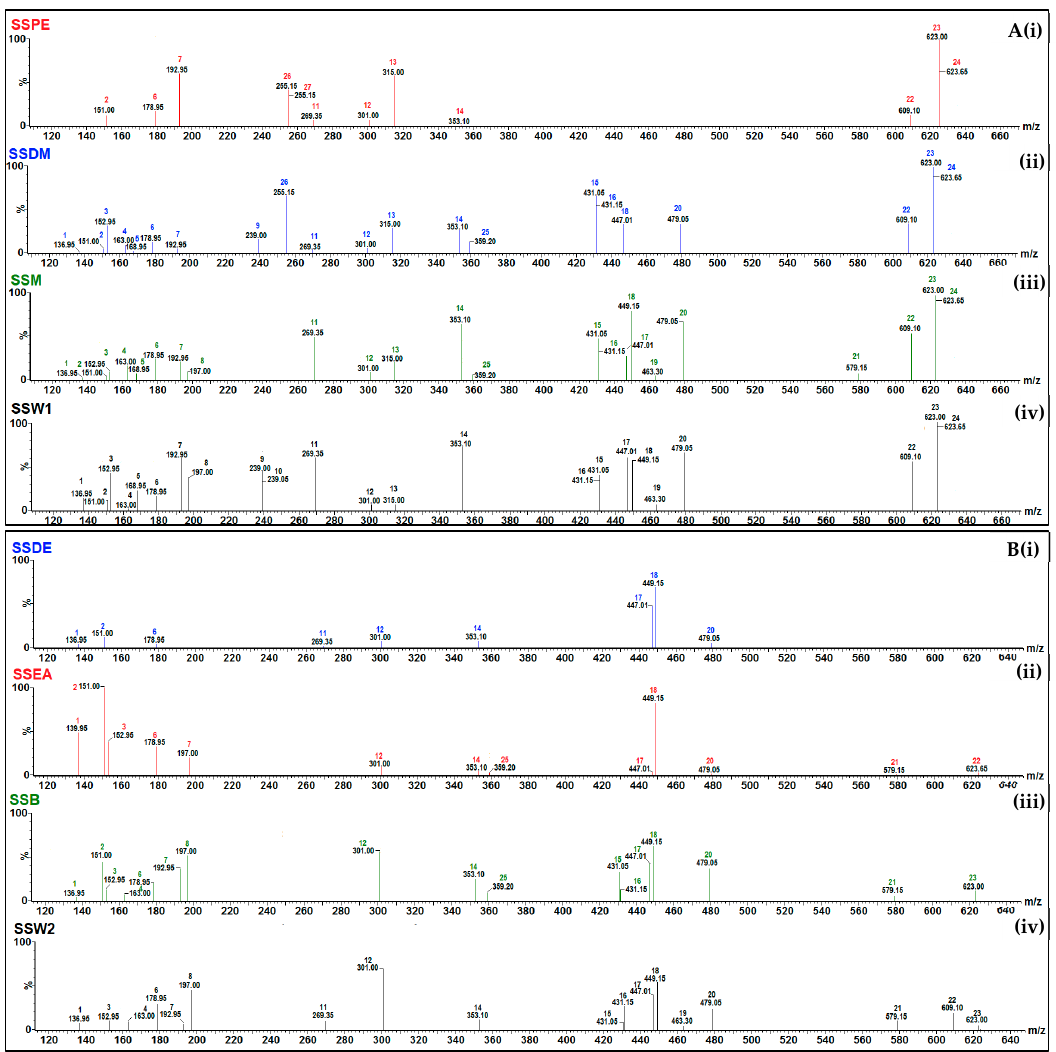
Figure 1. Selected ion recording (SIR) spectra: ( A ) ( i ) the petroleum (SSPE), ( ii ) dichloromethane (SSDM), ( iii ) methanolic (SSM), and ( iv ) initial aqueous (SSW1) isolated extracts and ( B ) the fractions of the methanolic extract ( i ) diethyl ether (SSDE), ( ii ) ethyl acetate, ( iii ) organic-phase butanol (SSB), and ( iv ) aqueous-phase butanol (SSW2) of S. scardica . Scanning (m/z; 120–650) was carried out utilizing collisions energies and m/z in the negative and positive electrospray ionization (ESI±) mode in accordance with the collision energy as presented in Table S1: 1 —4-hydroxybenzoic